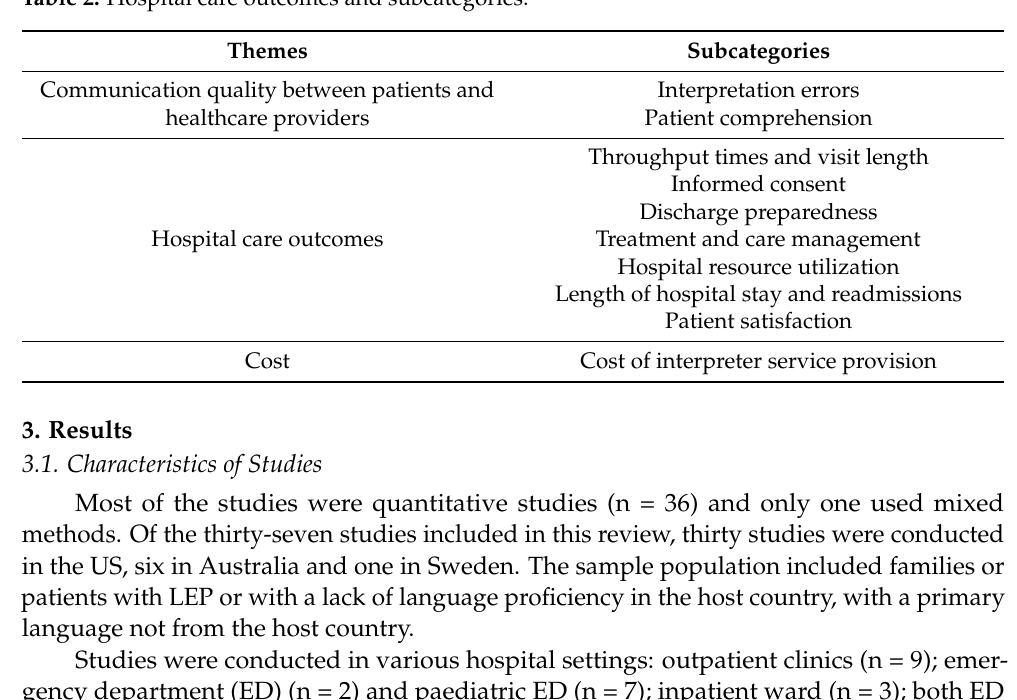
Table 2. Hospital care outcomes and